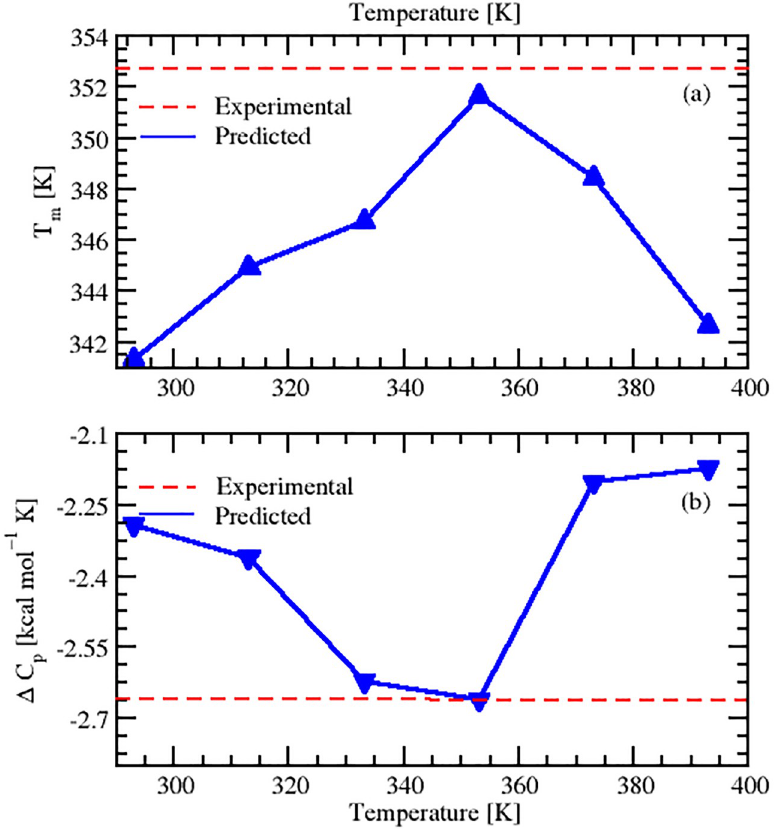
Fig 9. Variation of melting temperatures and heat capacities as a function of temperature. Predicted melting temperatures T (a) and heat capacities (b) at unfolding for different conformations of SazCA. The experimental T m and Δ C of the crystal structure have also been plotted for comparison with dashed P